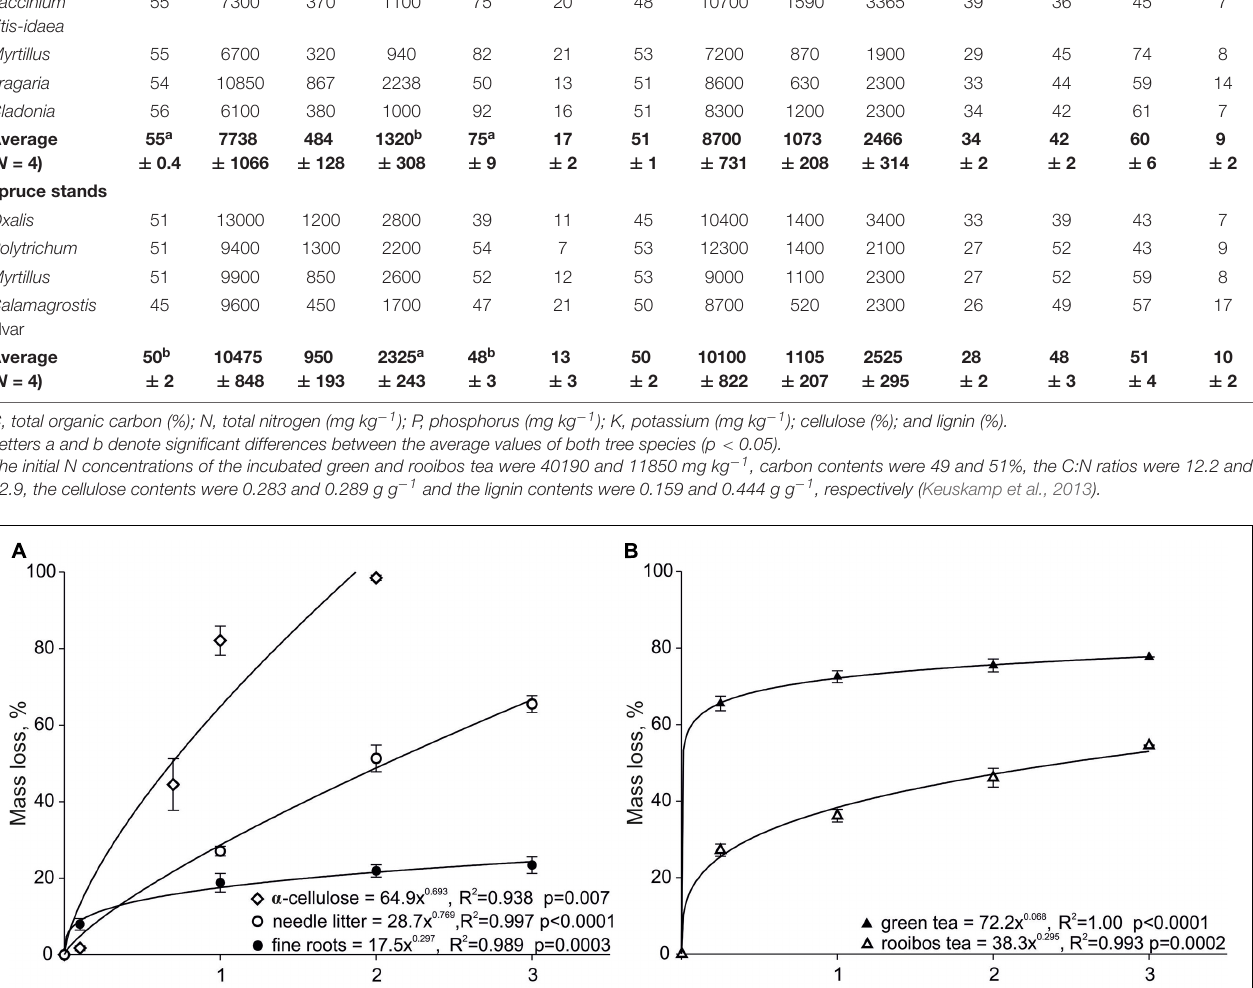
Figure 1 ). Among the latter, the decomposition time explained about 52% of variation in mass loss and correlated best with the first axis and the mass loss of standard substrates and needle litter, while mass loss of fine roots correlated better with the second axis (14%) being related to stand productivity (B) and the average